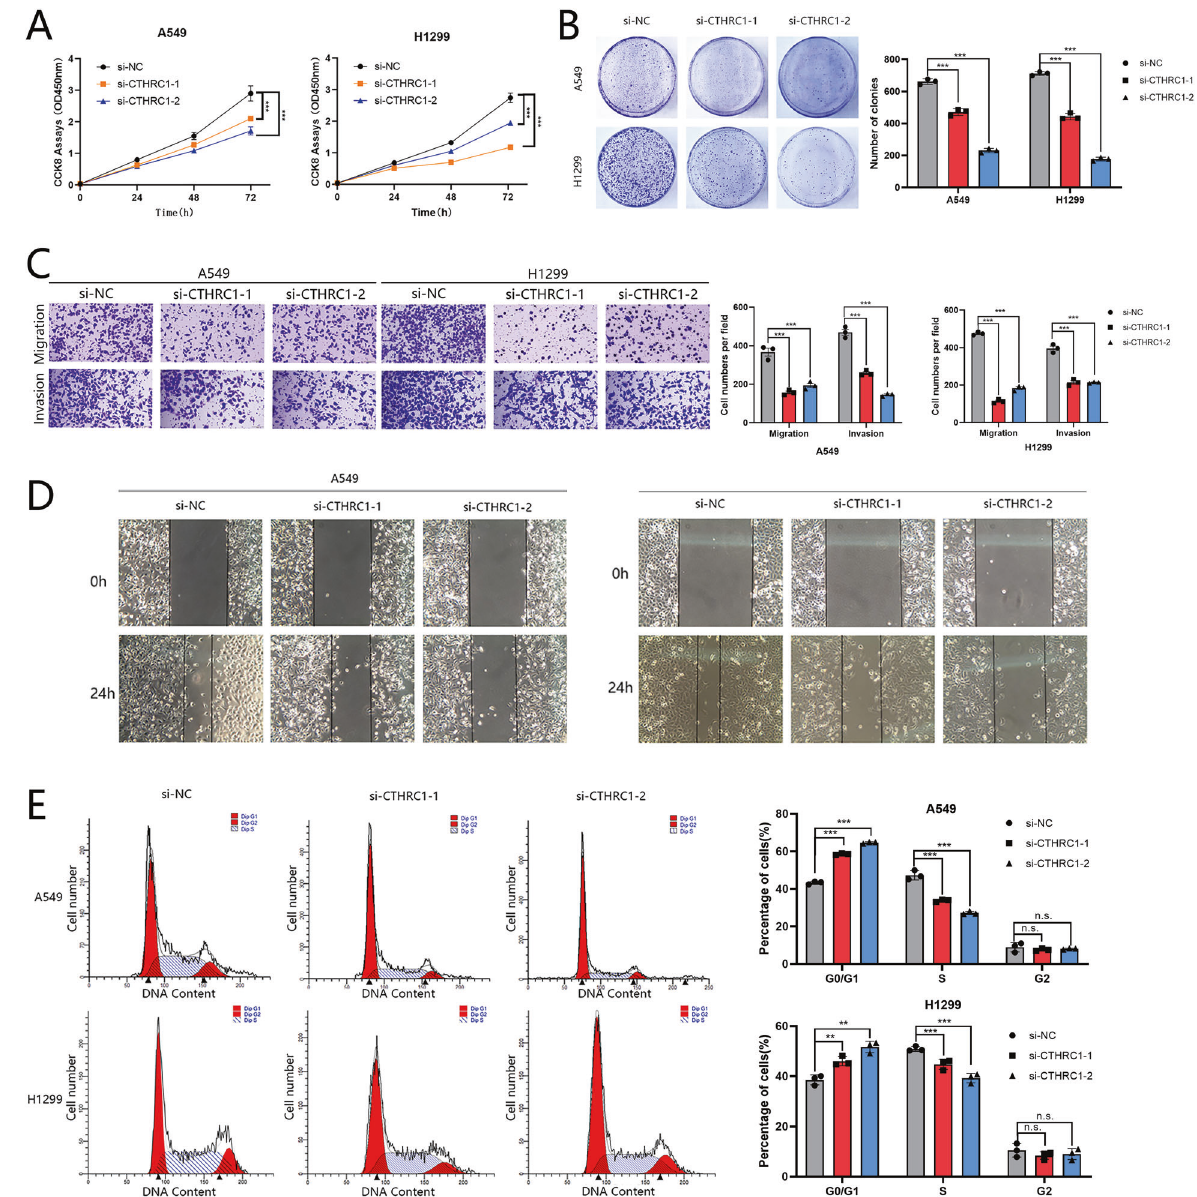
Fig. 4 Knockdown of CTHRC1 suppressed cell proliferation and metastasis, and reduced viability. A , B The capability of cell proliferation of A549/H1299 cells transfected with si-CTHRC1 or NC was detected by CCK-8 assay and colony formation analysis. C , D Transwell assay and